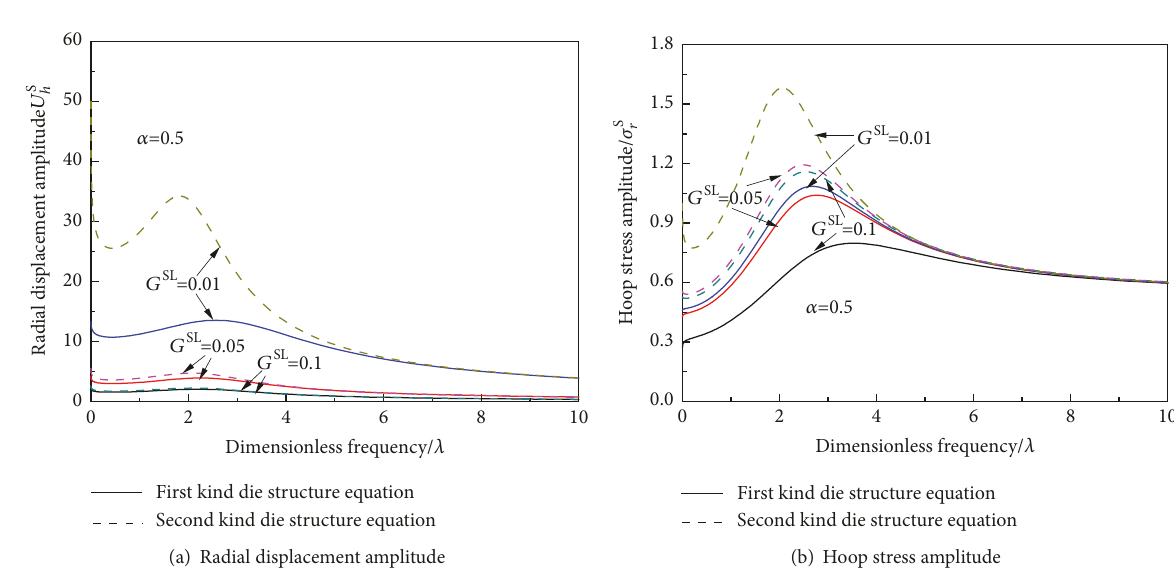
Figure 3: Comparison analysis of three models.